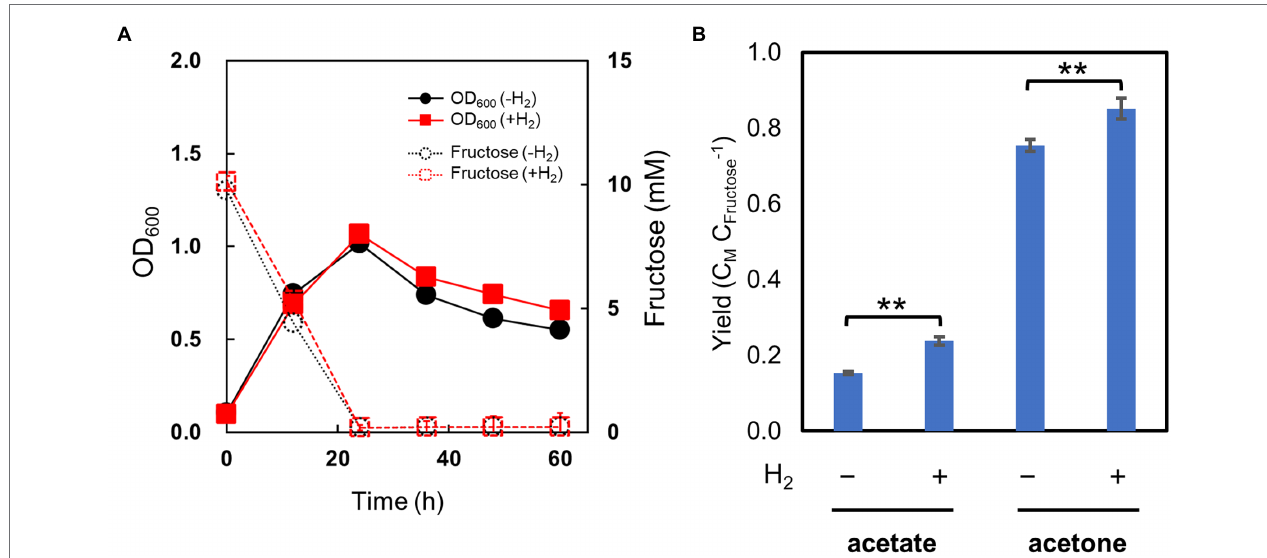
FIGURE 6 | Culture profiles of the metabolically engineered strain of Moorella thermoacetica for acetone production in the H 2 -supplemented mixotrophic condition. (A) shows cell growth (solid lines) and fructose consumption (dotted lines) in the absence (black) and presence (red) of H 2 . (B) shows carbon molar yields for acetate and acetone production. Error bars represent the SD of three biological replicates, some of which are smaller than